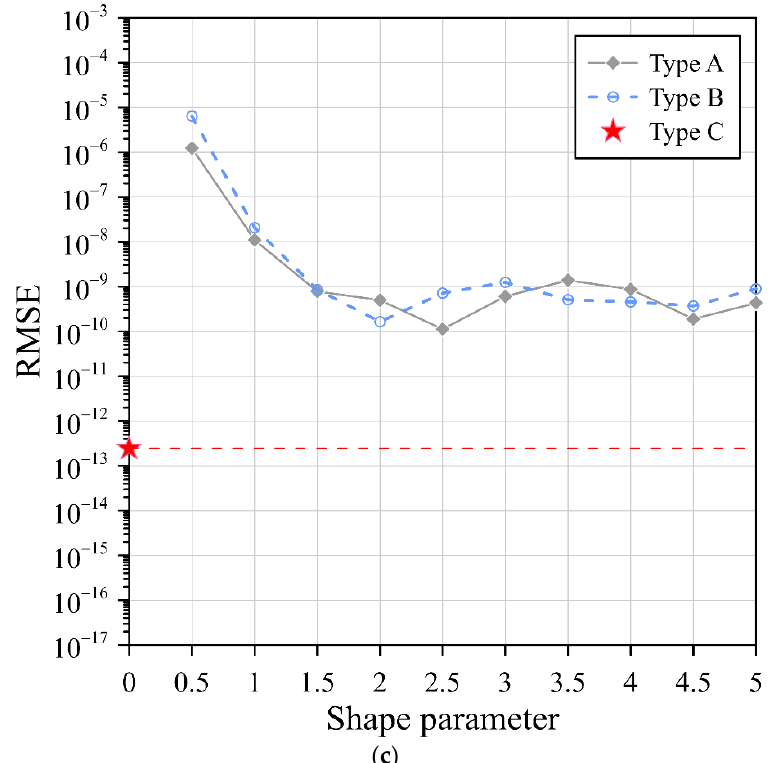
Figure 5. RMSEs of three RBFs using three different collocation types: ( a ) Gaussian RBF, ( b ) MQ RBF, and ( c ) IMQ RBF.